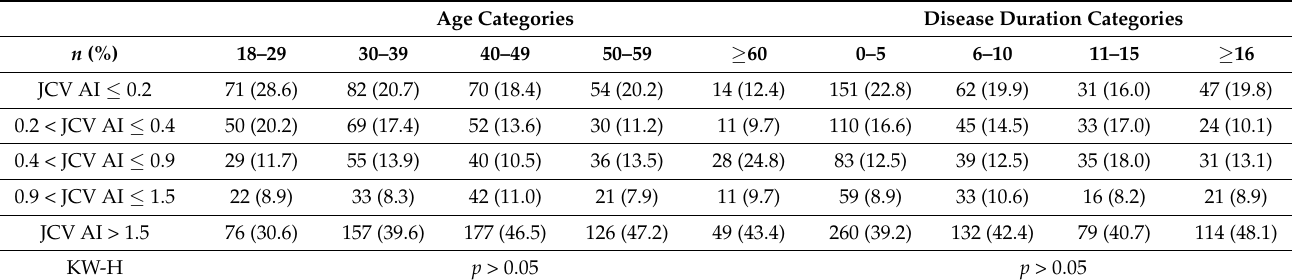
Table 6. Anti-JCV AI categories and patient’s age and disease duration.